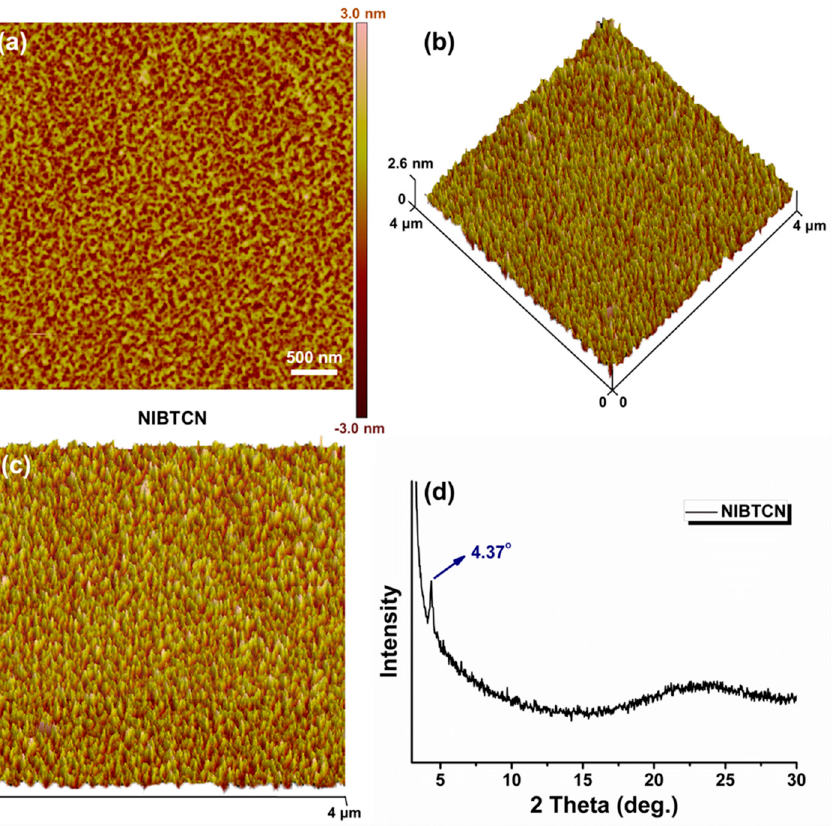
Figure 2. ( a ) AFM image of NIBTCN film. ( b , c ) 3D-AFM images of NIBTCN film: ( b ) an angle view; ( c ) a top view. ( d ) XRD pattern of NIBTCN film.